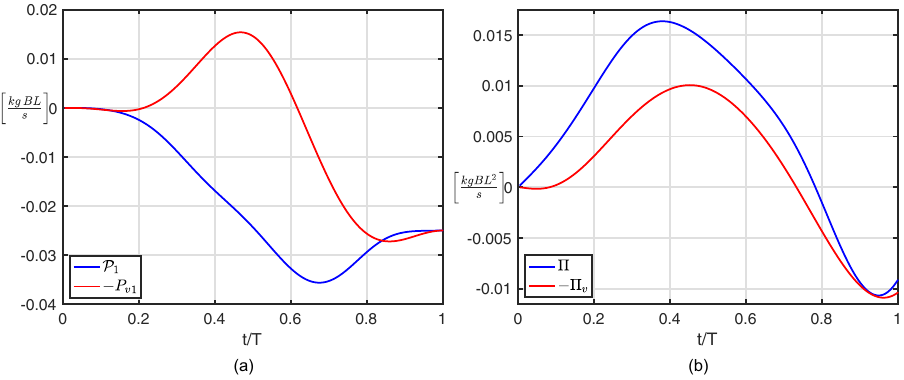
Figure 3. Fluid impulses for C-start maneuver: ( a ) total forward impulse P 1 and its vortical contribution P v 1 ; ( b ) total angular impulse (cid:31) and its vortical contribution (cid:31) v